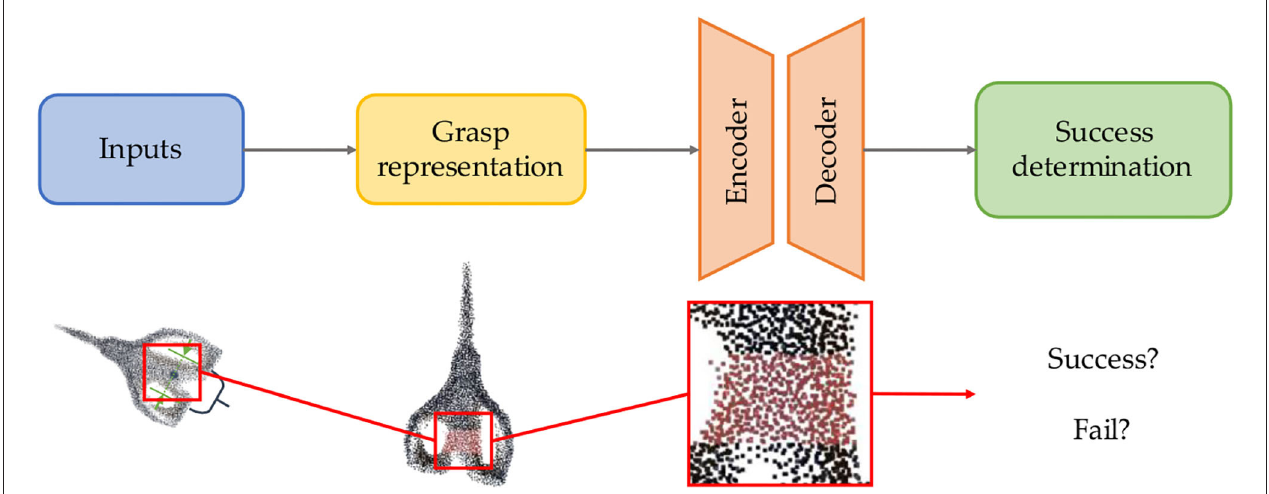
FIGURE 6 | Learning-based candidate evaluation (The scissors point cloud is from YCB